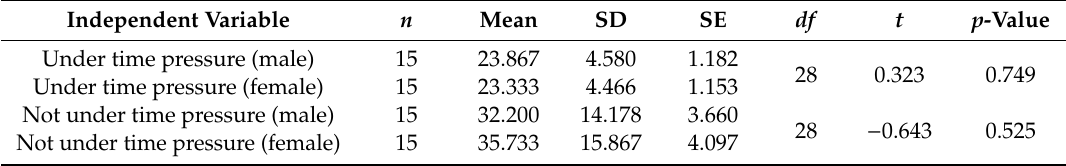
Table 3. Independent t -test results for gender di ff erences in the number of products viewed.